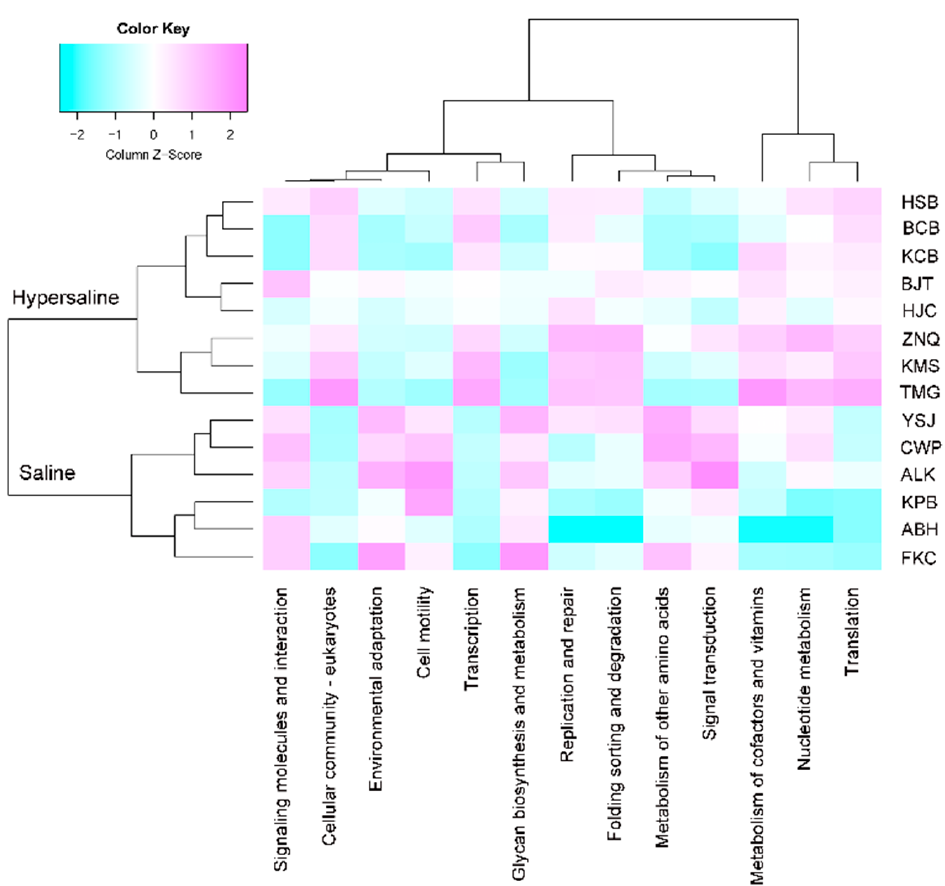
negatively correlated with abundance of Bacteroidetes, Actinobacteria, proteobacteria, and Planctomycetes (Figure 10C).